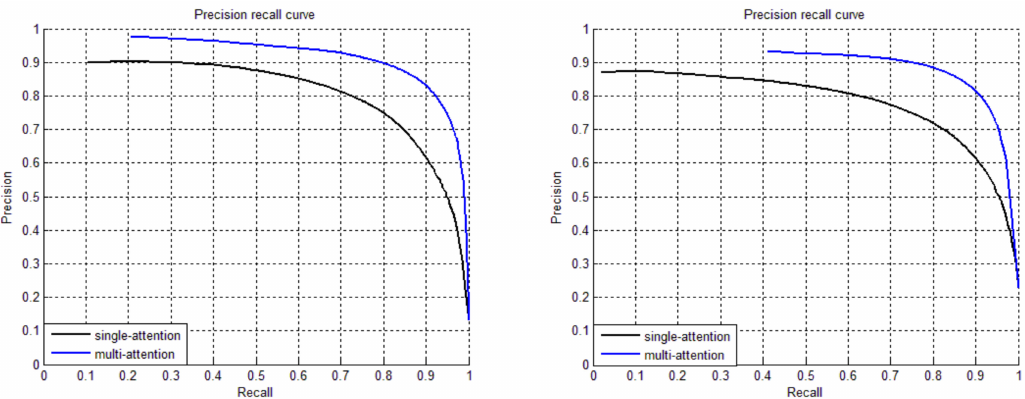
Figure 4. Precision–recall curves obtained from ablation study applied to images from NJUD (left) and NLPR (right)